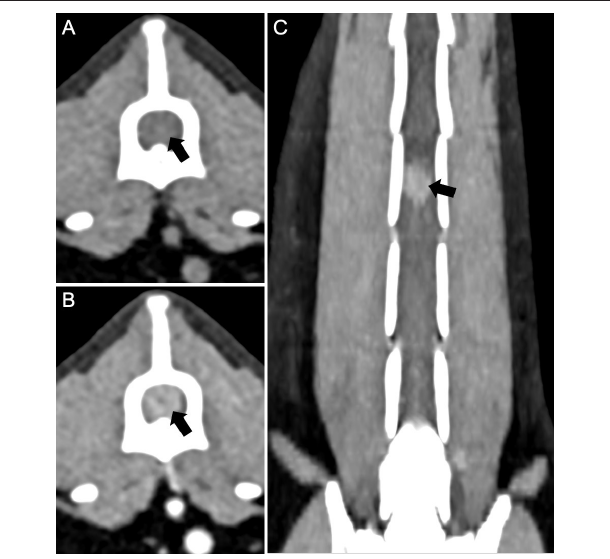
FIGURE 3 | Computed tomography of the lumbar spine in a cat with a compressive Coccidioides spp. spinal granuloma before surgery or administration of fluconazole. (A) Transverse plane reconstruction, pre-contrast series with soft tissue display. There was enlargement of the spinal cord silhouette (black arrow) that attenuated the epidural fat circumferentially; (B) Transverse plane reconstruction, post-contrast series with soft tissue display, and (C) Dorsal plane reconstruction, post-contrast series. There was diffuse, strong contrast enhancement of the enlargement of the spinal cord silhouette (black